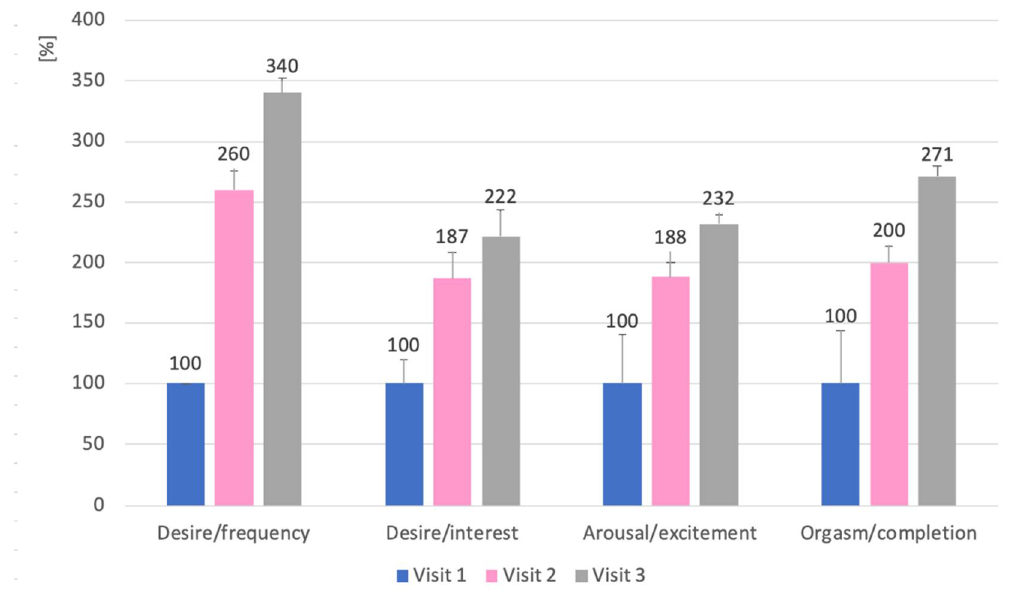
Figure 2. Change in mean values (+SD) of the CSFQ subscales at Visit 2 and 3 versus the values obtained by patients ( n = 5) at Visit 1. Results are expressed as a percentage of the values at Visit 1 treated as 100%. Table 1 . Significance of the differences between the first and the last visit in CSFQ subscales.